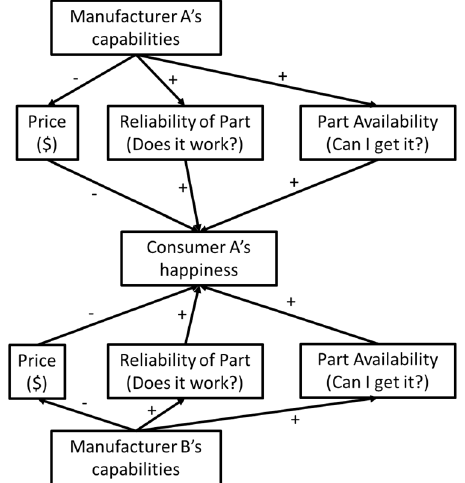
Figure 7. Cognitive map from manufacturer’s perspective